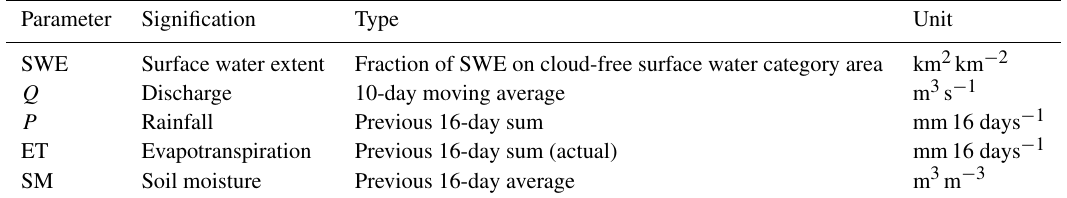
Figure 2. Overview of the analysis design and spatial modeling framework. Sources: river network (Commonwealth of Australia (Bureau of Meteorology), 2012), surface water categories derived from Kingsford et al. (2004), and eco-hydrological zonation (Huang et al., 2013). Table 3. Definition of model parameters per grid